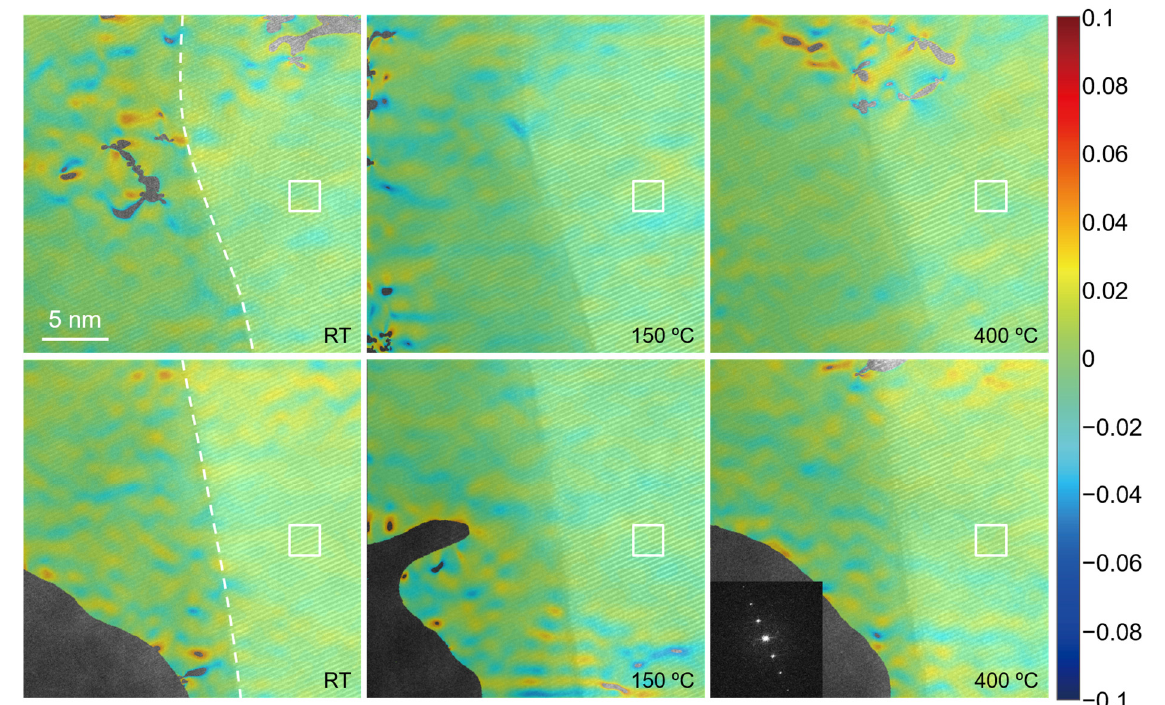
Figure 9. STEM-EDS maps of region 4 in Figures 3 and 4.